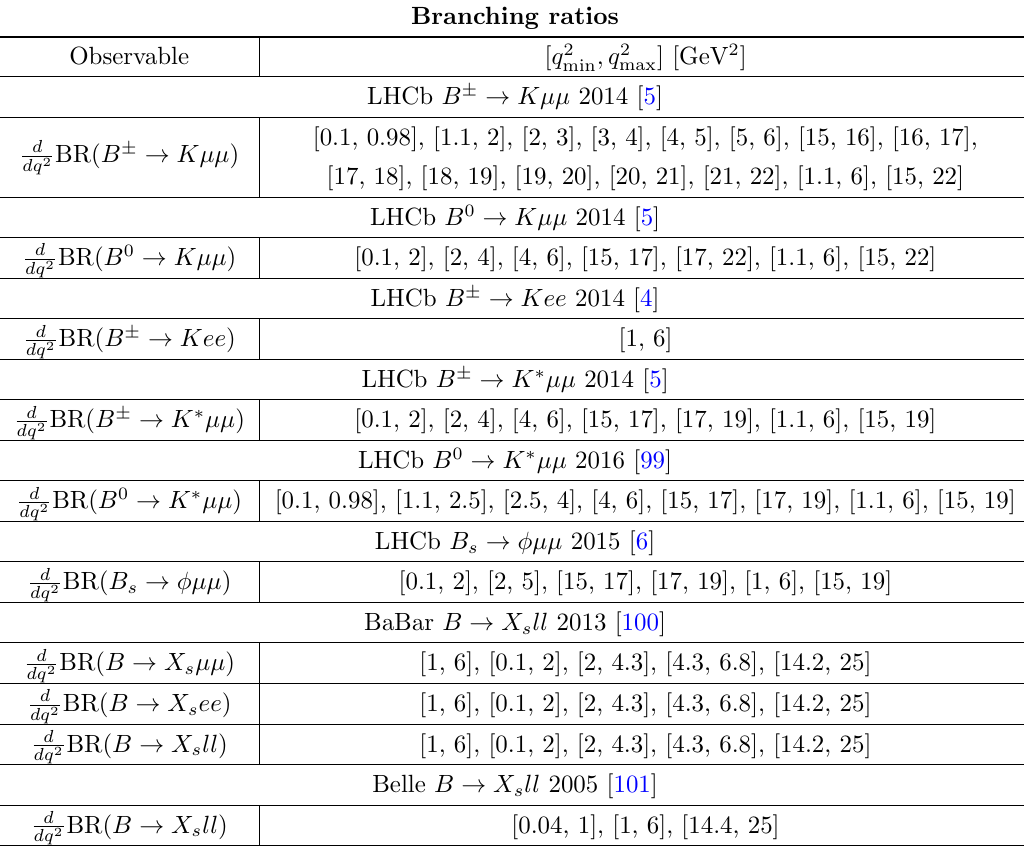
Table 7 . List of di(cid:11)erential branching ratios used in the global (cid:12)t in addition to the ‘clean’